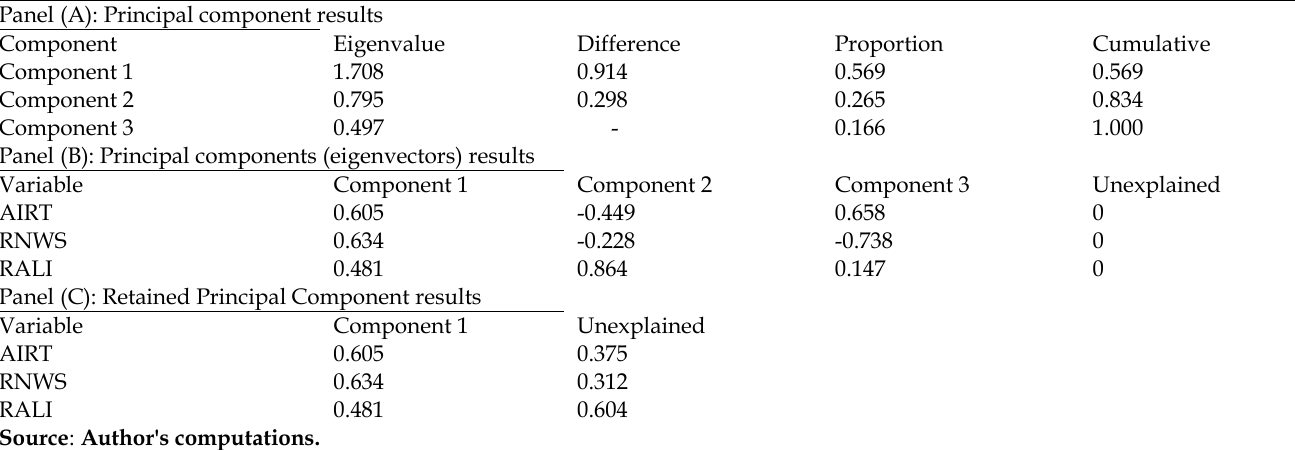
Table 3: Principal component